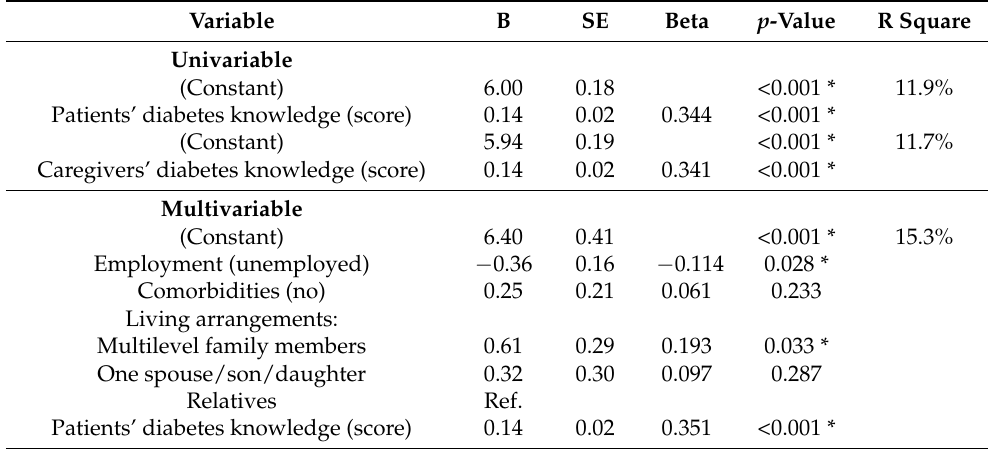
Table 4. Relationship between diabetes knowledge for both groups and patients’ self-care behaviors.